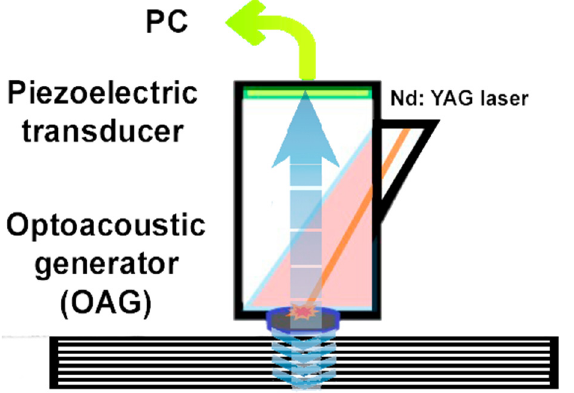
Figure 7. Schematic diagram of optoacoustic generator.